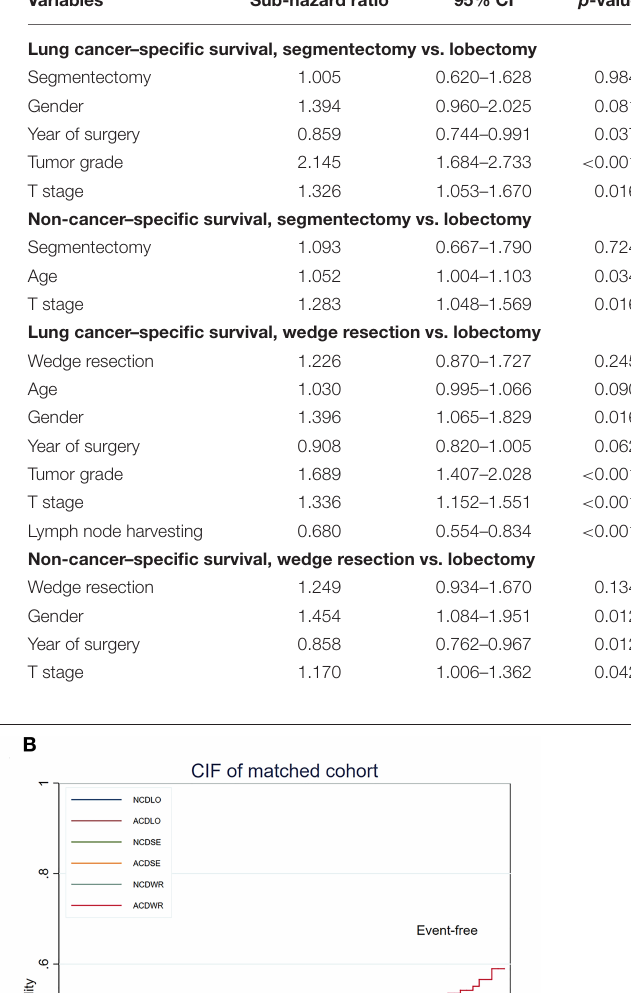
TABLE 3 | Multivariate competing risks analyses.